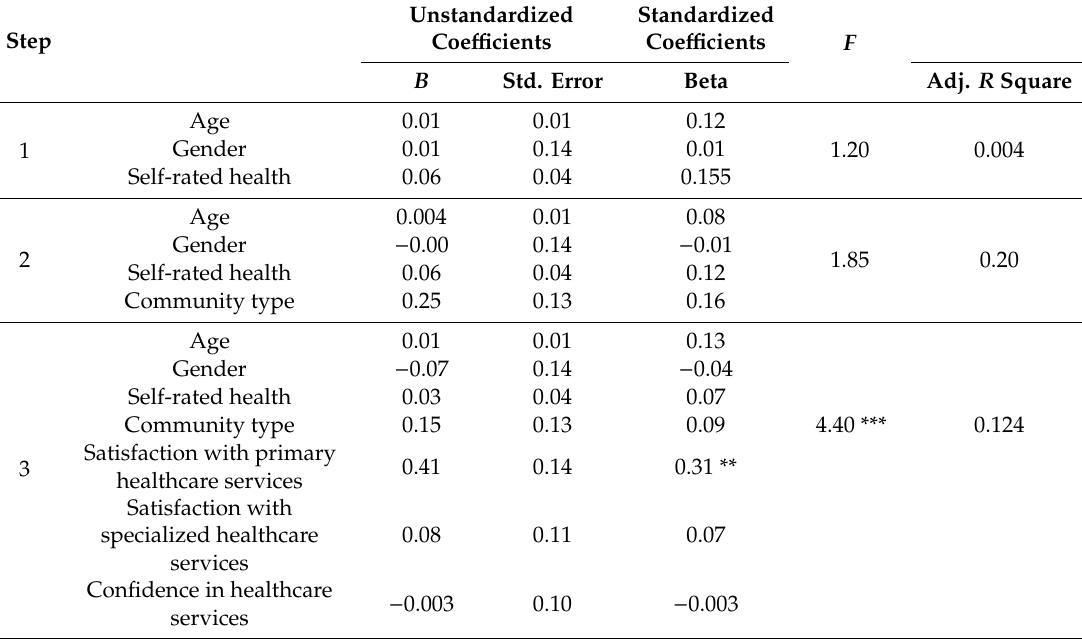
Table 3. Multiple regression analyses predicting community resilience by satisfaction and confidence in health-care